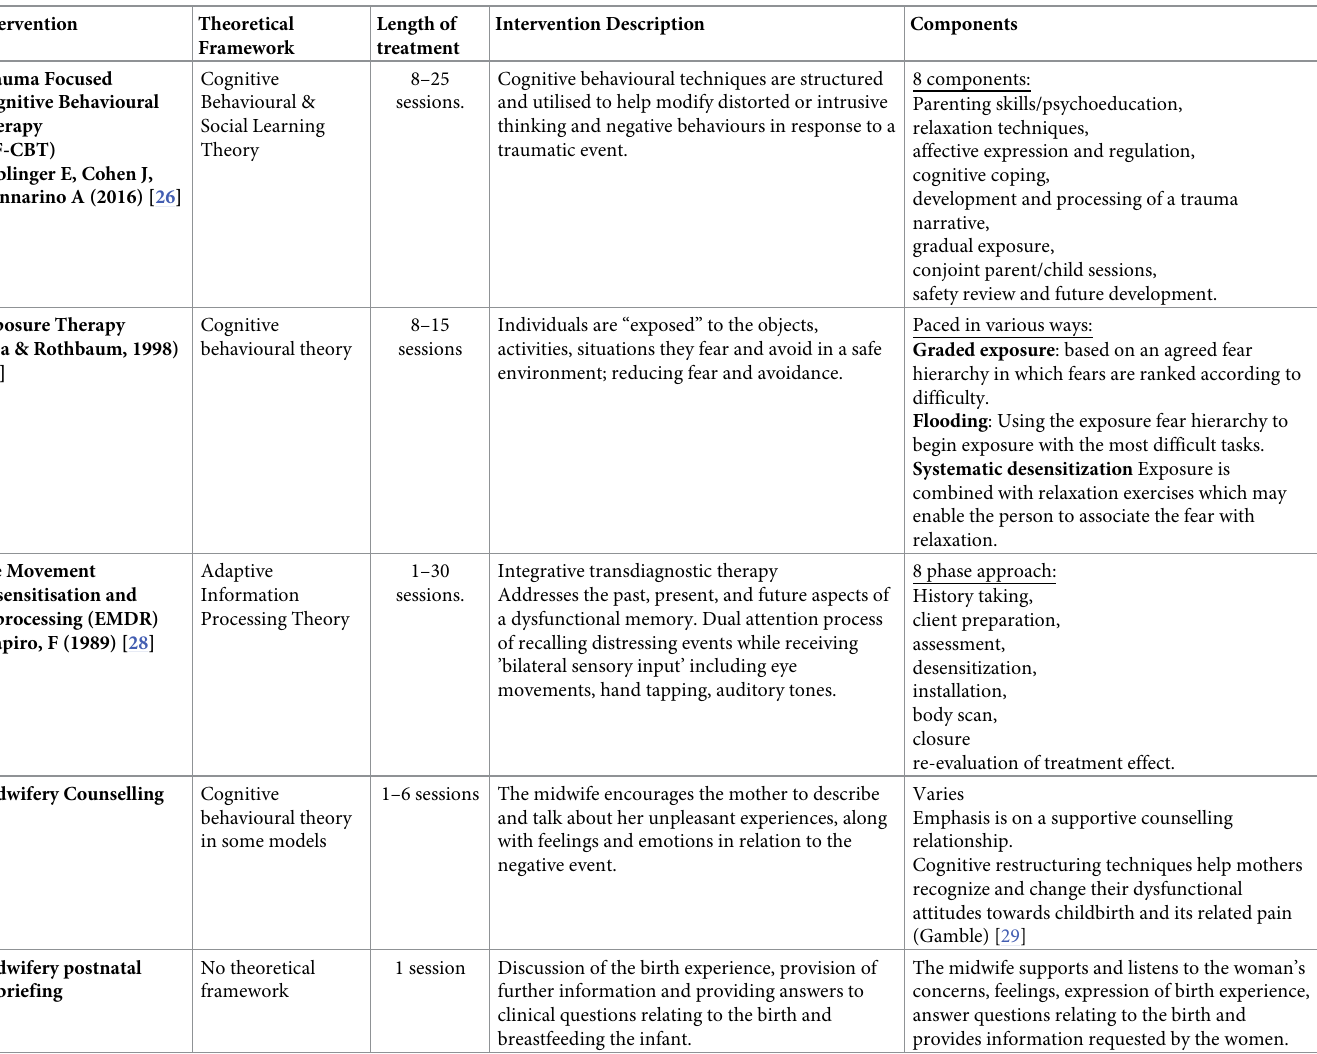
Table 1. Description of early treatment interventions for post-traumatic stress